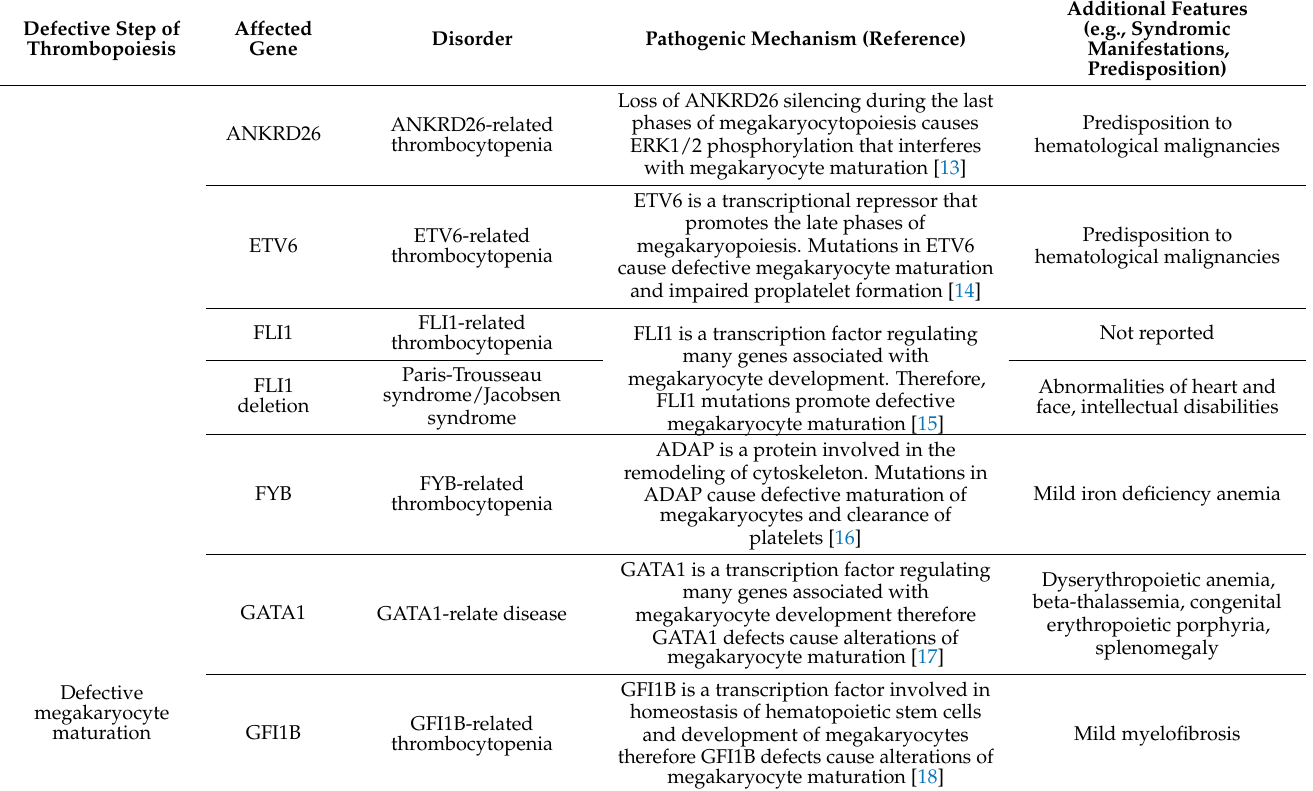
Table 1. IT classified based on the defective step of platelet count regulation